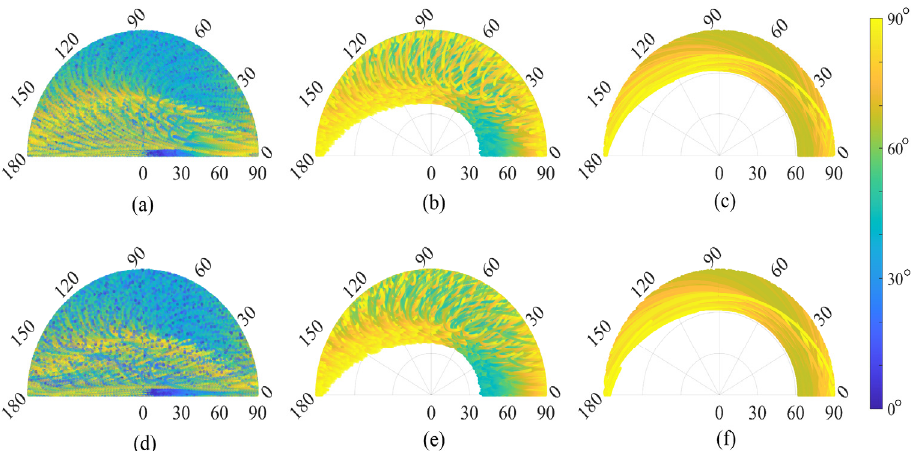
Figure 5. Angular combination distribution of ( a ) Point C, ( b ) Point B, ( c ) Point A, ( d ) Point E, ( e ) Point F, and ( f ) Point G. (The polar axis represents the relative azimuth angle, polar diameter represents the viewing zenith angle, and color represents the solar zenith angle).